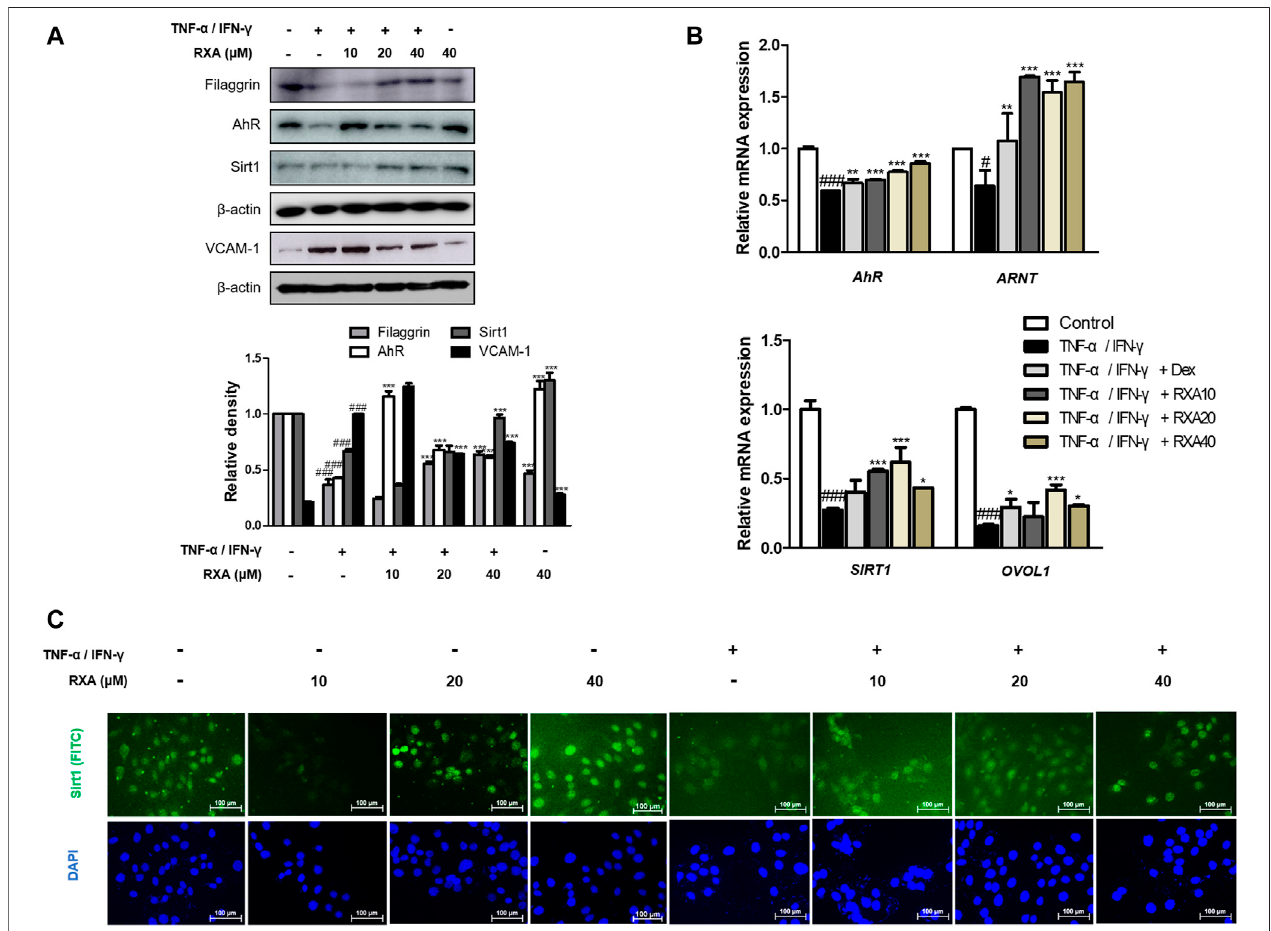
FIGURE 5 | Effects of RXA on the expression of fi laggrin, AhR, and SIRT1 in TNF- α /IFN- γ -stimulated HaCaT keratinocytes. HaCaT keratinocytes were pre-treated withRXAandthenstimulatedwithTNF- α /IFN- γ . (A) TotalproteinswerepreparedandanalyzedbytheWesternblottingtechniquefor fi laggrin,AhR,SIRT1,andVCAM-1, using speci fi c antibodies. (B) The mRNA levels of AhR, ARNT, SIRT1, and OVOL1 were determined by qRT-PCR. (C) Immuno fl uorescence staining of SIRT1 (green), treatedwithorwithoutTNF- α /IFN- γ ,inHaCaTkeratinocytes.Nucleiwerecounterstained usingDAPI(scalebar (cid:1) 100 μ m).Thedatashownrepresentmean ± S.D. of three independent experiments. # p < 0.05, ### p < 0.001 vs. the control group; * p < 0.05, ** p < 0.01, and *** p < 0.001 vs. TNF- α /IFN- γ -stimulated group. ARNT, aryl hydrocarbon receptor nuclear translocator; OVOL1, OVO-like 1; Dex,